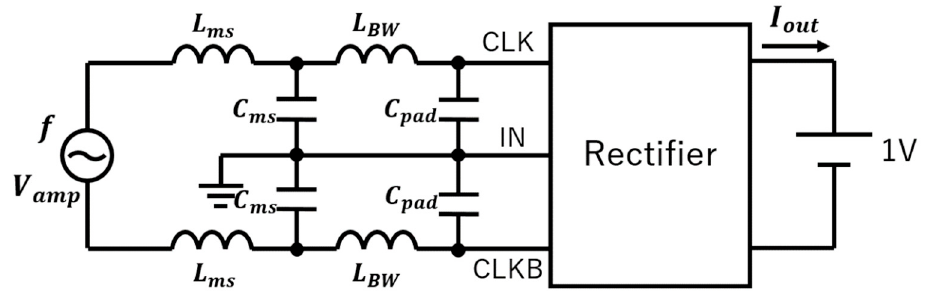
Figure 13. Schematic for SPICE simulation including parasitic elements in microstrip lines and bonding wires.